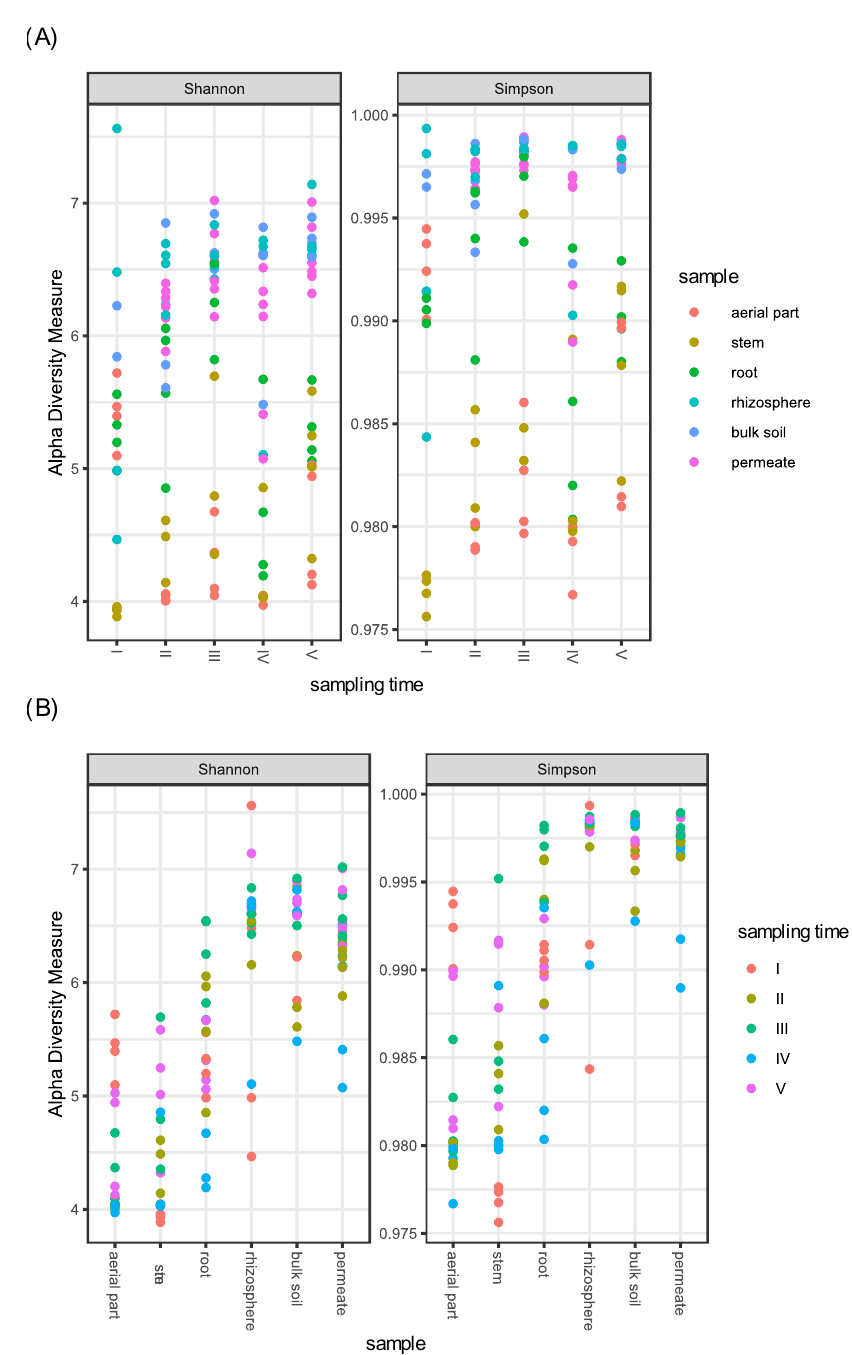
Figure 1. Shannon and Simpson diversity indices of the bacterial communities associated to P. australis , soil, and permeate samples collected in the CW during five samplings. ( A ) Samples are divided per sampling time. ( B ) Samples are divided per compartments.